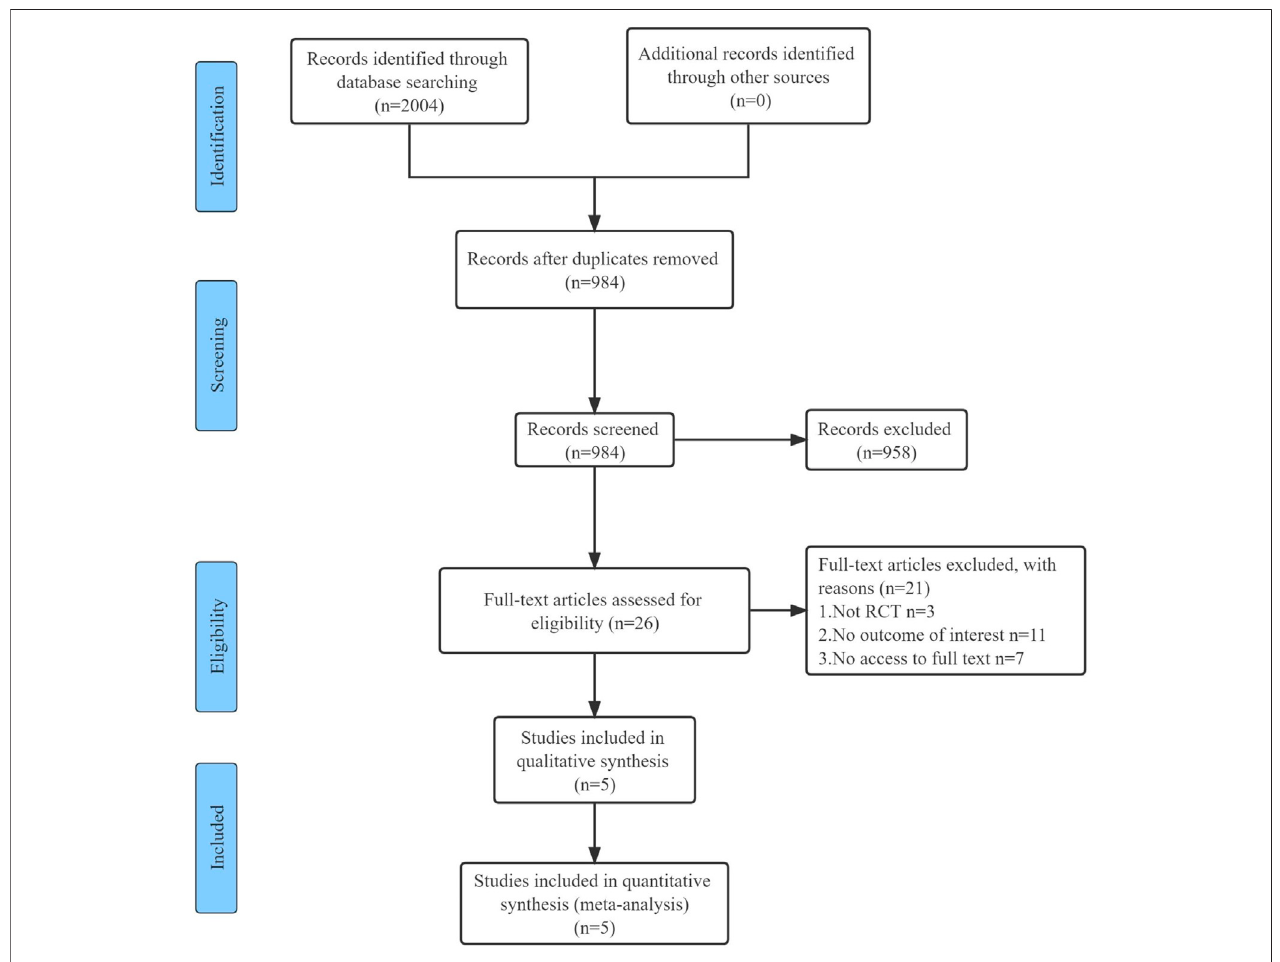
FIGURE 1 | PRISMA fl ow diagram of the trial selection. RCT, randomized controlled